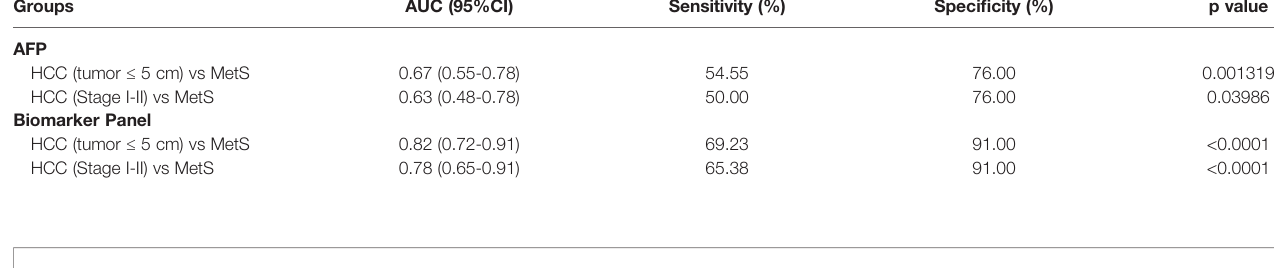
TABLE 4 | The diagnostic performance of the biomarker panel for the detection of small and early-stage HCC in MetS population. Groups